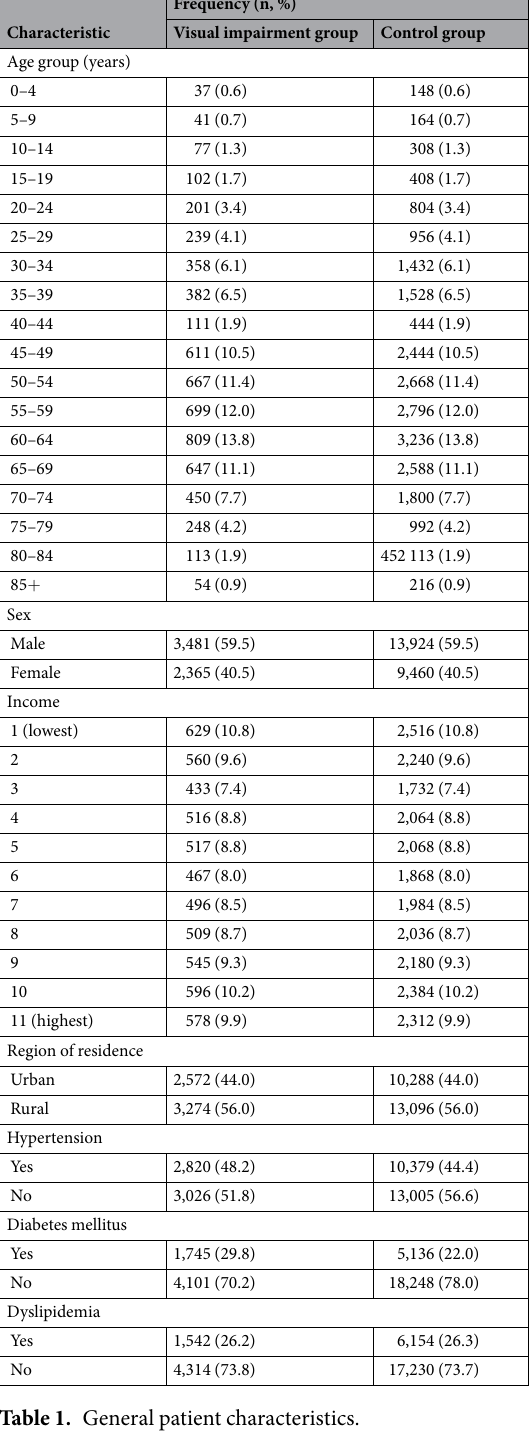
Table 1. General patient